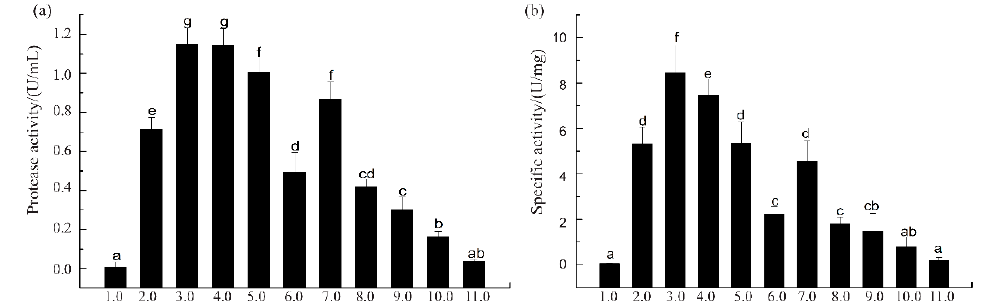
Figure 2. Protease activity ( a ) and specific activity ( b ) of the extracted crude enzymes by isoelectric solubilization/precipitation (ISP) method, using casein as substrate. Different letters indicate significant differences between two compared groups ( p < 0.05).